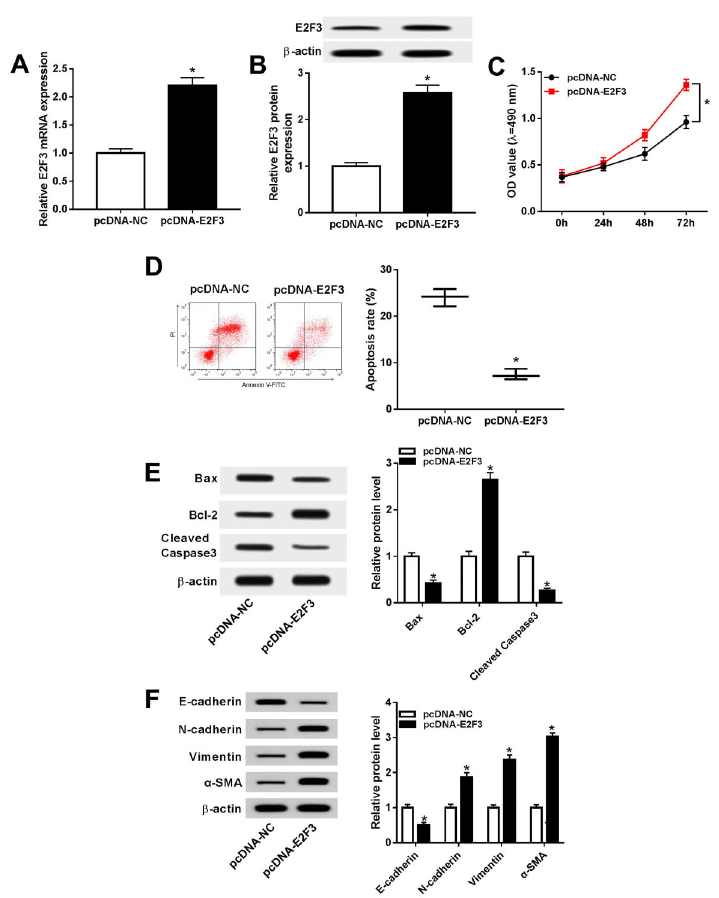
Figure 3. A and B, The expression of E2F3 mRNA and protein in transfected SRA01/04 cells was examined by qRT-PCR and western blot, respectively. C, Measurement of cell proliferation was carried out by MTT. D , Analysis of cell apoptosis was performed through fl ow cytometry. E and F , Protein expression of Bax, Bcl-2, and cleaved caspase 3 ( E ), as well as the protein levels of E-cadherin, N-cadherin, vimentin, and a -SMA ( F ), was assessed by western blot. Data are reported as means ± SD. *P o 0.05 ( t